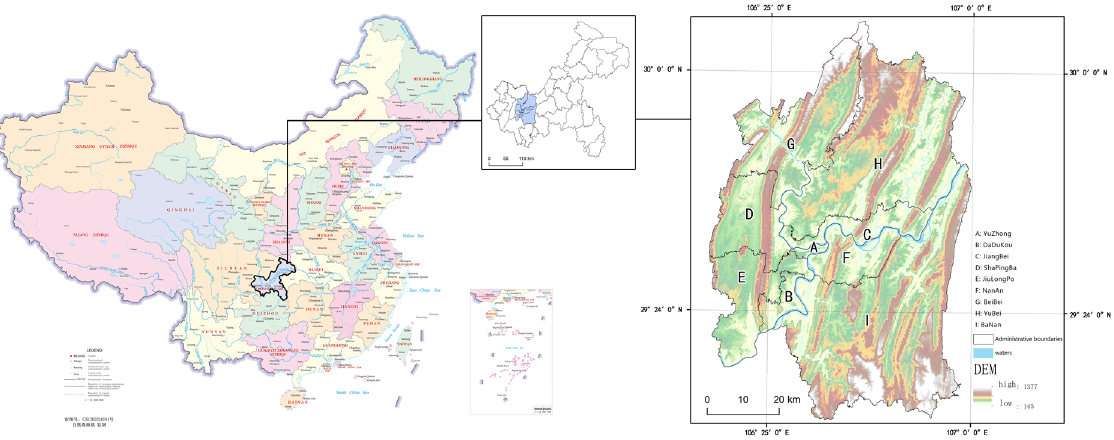
Figure 1. Map of Chongqing, China.